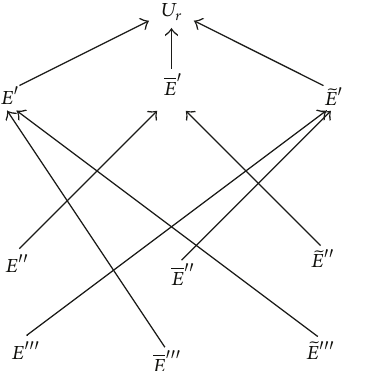
Figure 3: The causal structure of the RPS in a (2 + 1) -dimensional spacetime.